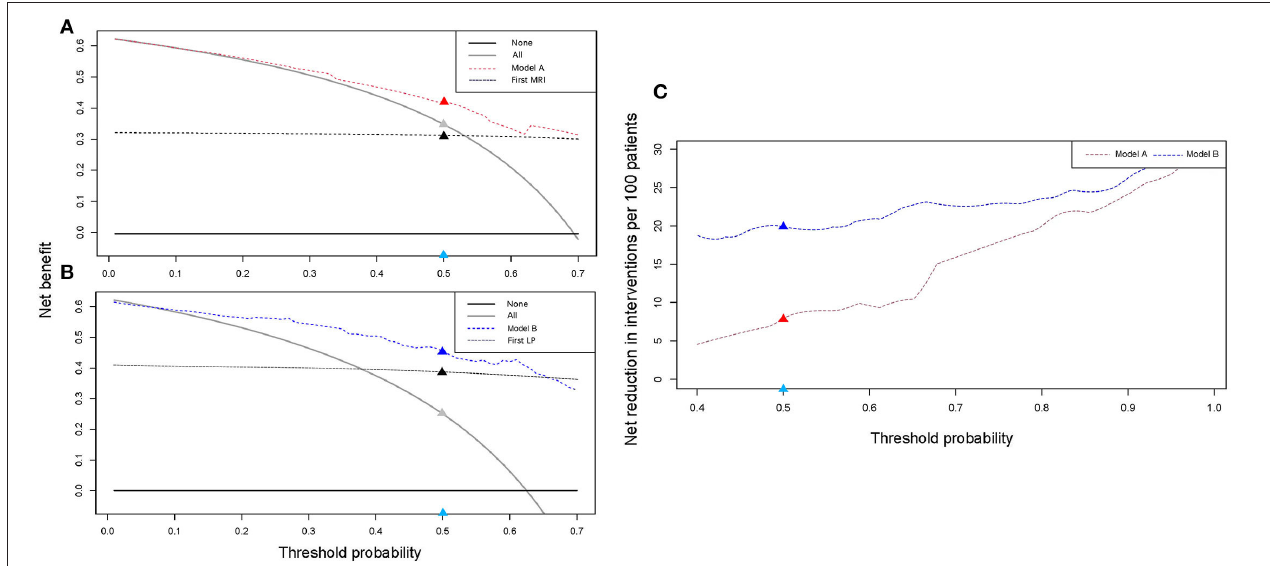
FIGURE 4 | Clinical application evaluation. DCA and IAA for models A and B reveal a net benefit in the clinical decision compared to “treat all” or “treat none” and net reduction in unnecessary intervention. (A,B) DCA curves for models A and B. Compared with the first MRI, model A exhibits a net benefit when the threshold was < 0.7. Compared with the first LP, model B exhibits a net benefit when the threshold was < 0.66. (C) IAA curves for models A and B. Models A and B can help avoid unnecessary interventions. For example, in (A) , when the threshold was set at 0.5 (the light blue dot), the corresponding net benefit by using model A (the red dot) was higher than that of “treat all” (the gray dot) and the first MRI (the black dot). In (C) , the net reduction in interventions was increased by using the models (the red and blue dots). DCA, decision curve analysis; IAA, interventions avoided analysis; LP, lumber puncture.